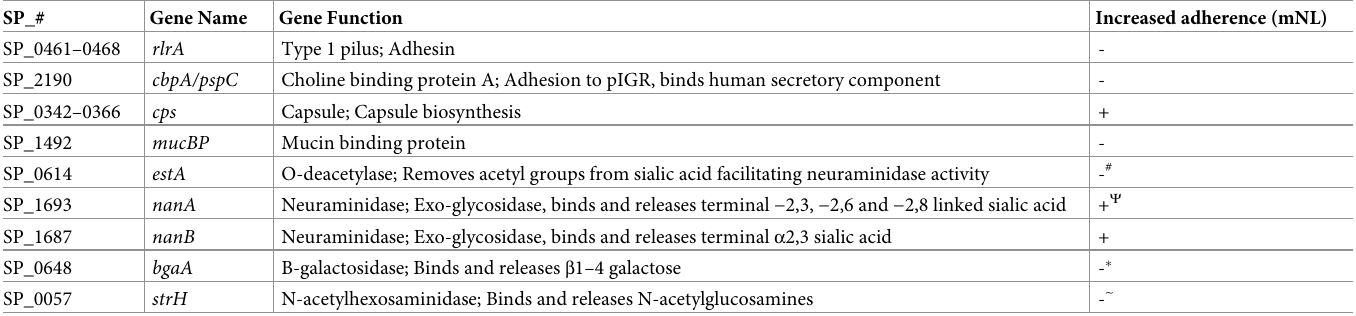
Effect observed with Type 23F. No significant effect in strain TIGR4 which expresses a truncated, secreted form of the enzyme ~ Only tested in the Type 23F background # Additionally, tested in hNF due to the difference in acetylation in humans versus mice